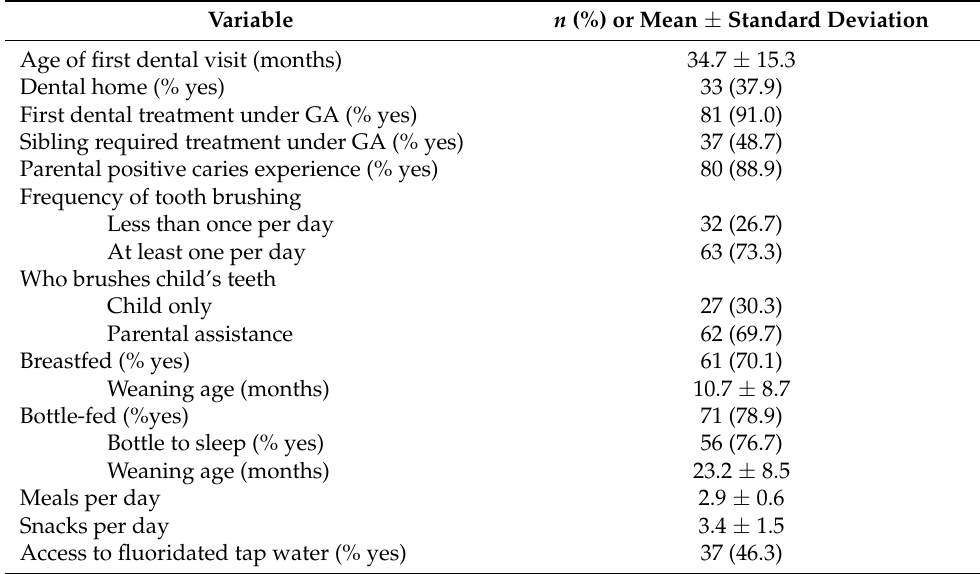
Table 2. Risk indicators for early childhood